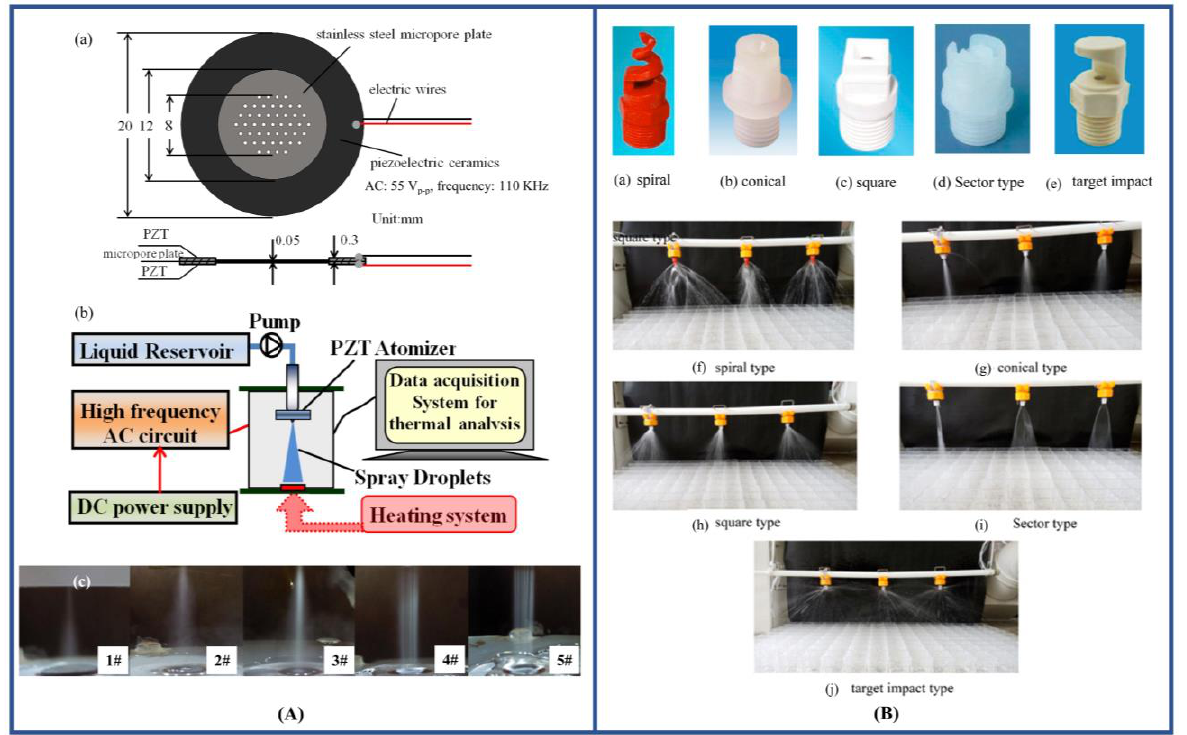
Figure 2. Different nozzle structure and spray distribution effect. ( A ): Piezoelectric atomizer sche- matic drawing ( a ); spray cooling system schematic diagram( b ); atomization images of different pi- ezoelectric atomizers ( c ) 1# atomizer (micropore outlet diameter of 5 μm), 2# atomizer (micropore outlet diameter of 7 μm), 3# atomizer (micropore outlet diameter of 9 μm), 4# atomizer (micropore outlet diameter of 20 μm), 5# atomizer (micropore outlet diameter of 25 μm) [64]. ( B ): five widely-